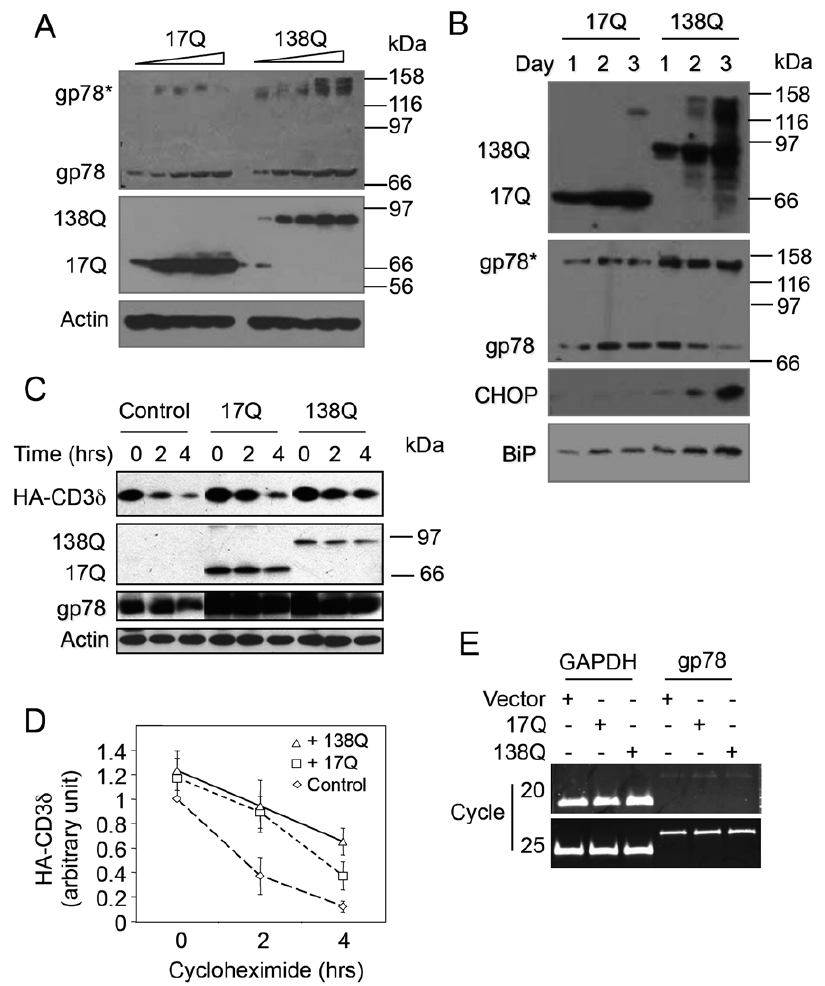
Figure 1. Nhtt overexpression upregulates gp78 protein and induces gp78 aggregation. A. Nhtt upregulates gp78 protein in a dose- dependent manner. Increasing amounts of Nhtt17Q and Nhtt138Q were expressed in HEK293 cells. Endogenous gp78 was examined by immunoblotting. Actin was blotted as a loading control. gp78* indicates aggregated gp78. B. Accumulation of Nhtt138Q causes increased aggregation of gp78 and induces ER stress. Equal amount of Nhtt17Q and Nhtt138Q were expressed in HEK293 cells. gp78, CHOP, and BiP were assessed in these cells by immunoblotting. C, D. Nhtt inhibits CD3 d degradation and polyglutamine expansion aggravates the inhibition. Nhtt17Q and Nhtt138Q were transfected into HEK293 cells that stably express CD3 d . CD3 d degradation in transfected cells was analyzed by cycloheximide (CHX) chase. D. Quantitative results of CD3 d degradation are expressed as mean + / 2 SD, n =3. After 2 hrs: vector vs. 17Q or 138Q, p , 0.05; after 4 hrs: vector vs. 17Q or 138Q, p , 0.05; 17Q vs. 138Q, p , 0.05, t -test. E. Neither Nhtt17Q nor Nhtt138Q affect gp78 mRNA expression. HEK293 cells expressing Nhtt17Q or Nhtt138Q were examined by RT-PCR of gp78 mRNA. GAPDH mRNA was amplified as a control.